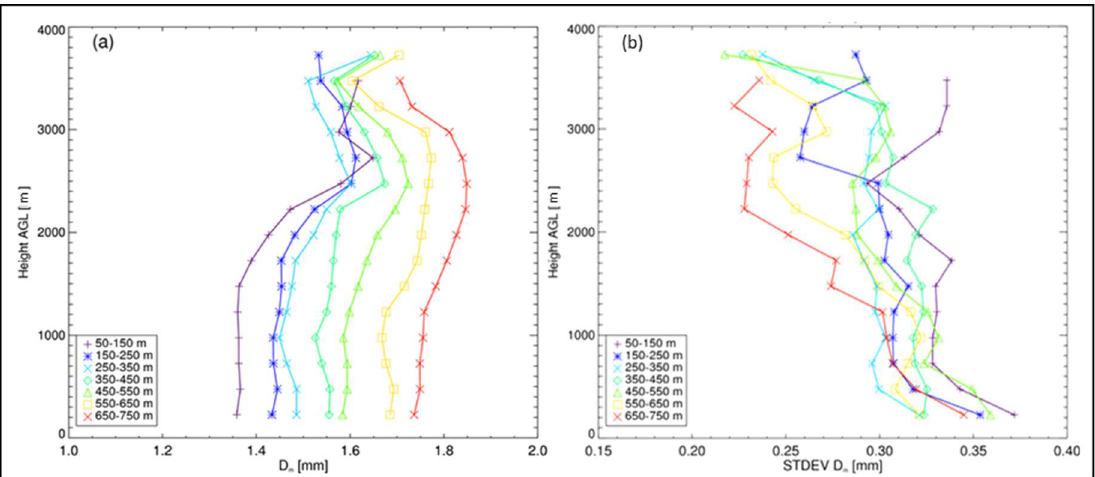
Figure 4. Vertical profile of ( a ) mean D m and ( b ) standard deviation of D m retrieved from dual-polarimetric radar measurements for the ML thicknesses listed in Table 3. The legend in the lower-left corners gives the radar-based ML thickness corresponding to each D m profile.